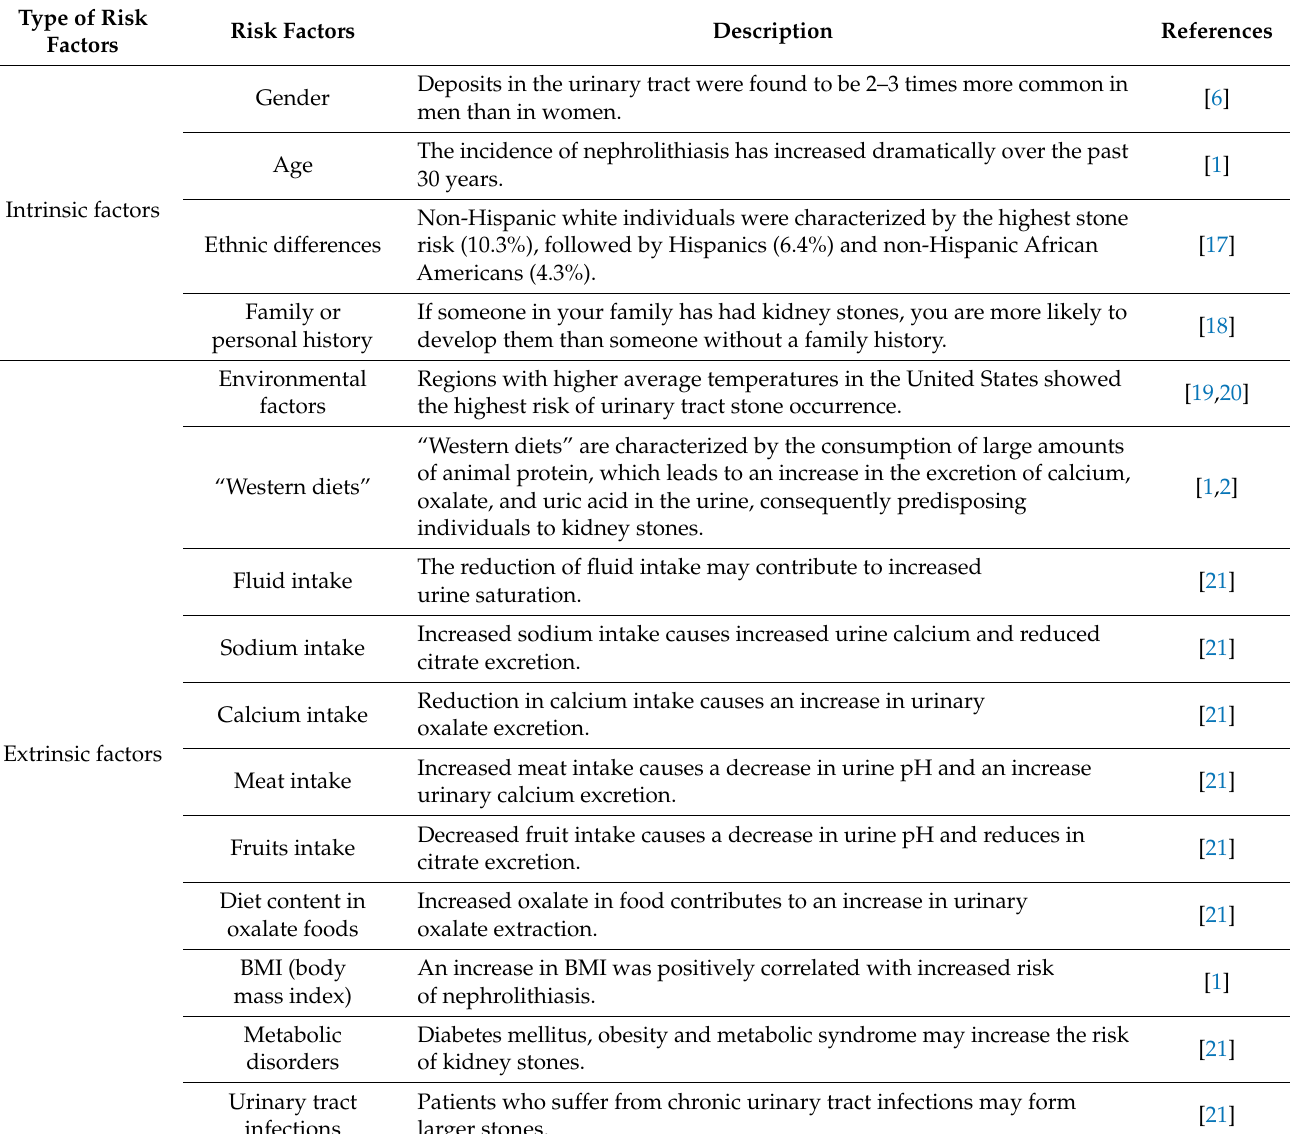
Table 1. Risk factors of nephrolithiasis